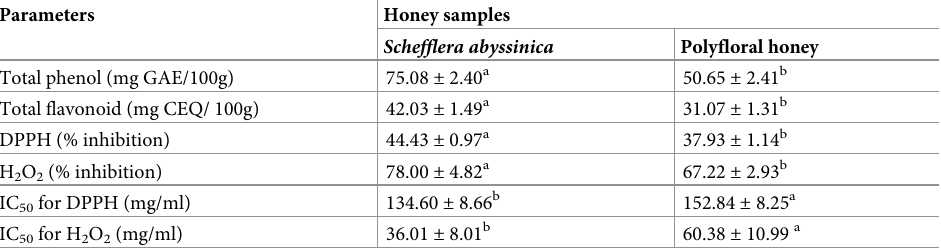
Table 2. Antioxidant content and antioxidant activities (mean ± SD) of Schefflera abyssinica and Polyfloral honey (n = 20).